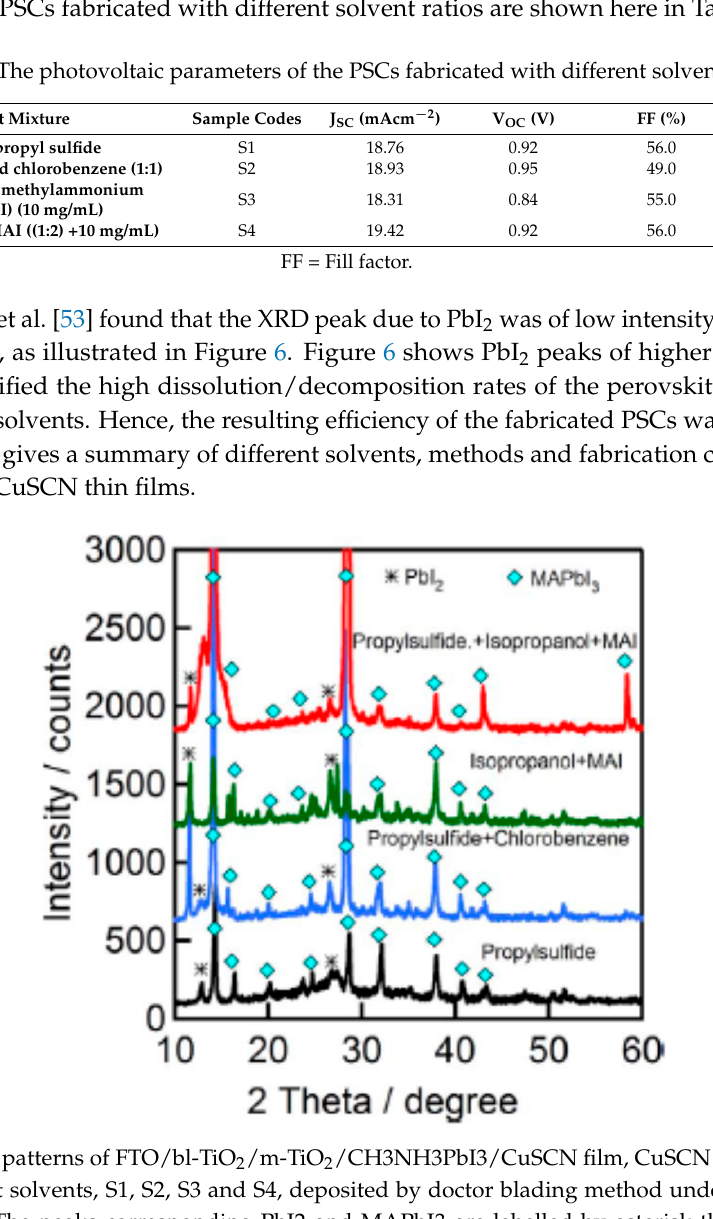
Table 1. The photovoltaic parameters of the PSCs fabricated with different solvent ration.